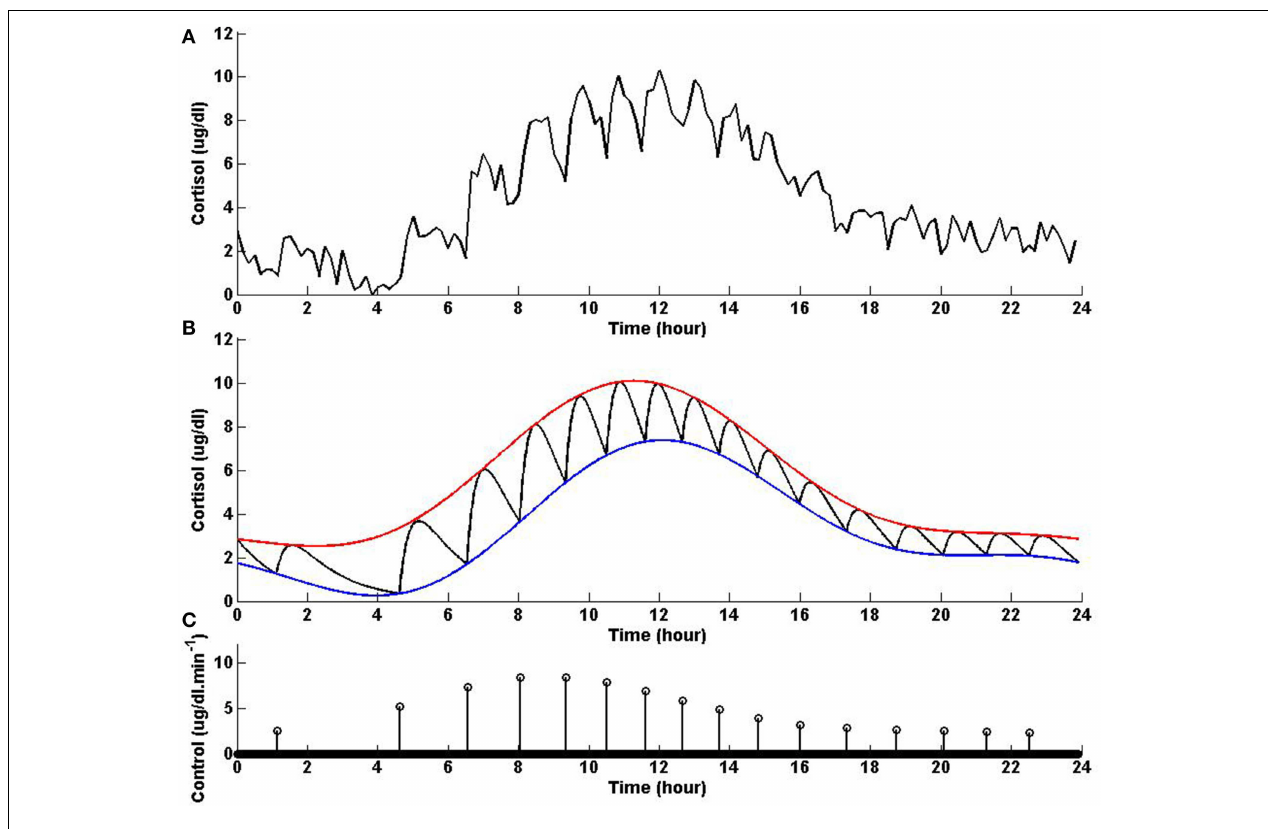
(C) The bottom panel displays the optimal control. The optimization problem obtained 16 impulses over 24 h as the optimal control (the timing of the control was discretized into 1440 points; the obtained control takes 16 non-zero values, i.e., impulses, while it is zero everywhere else). The optimization problem was solved using the parameters given in Example 2 in Table 1 and the upper and lower bounds provided in Tables 2 , 3 ,